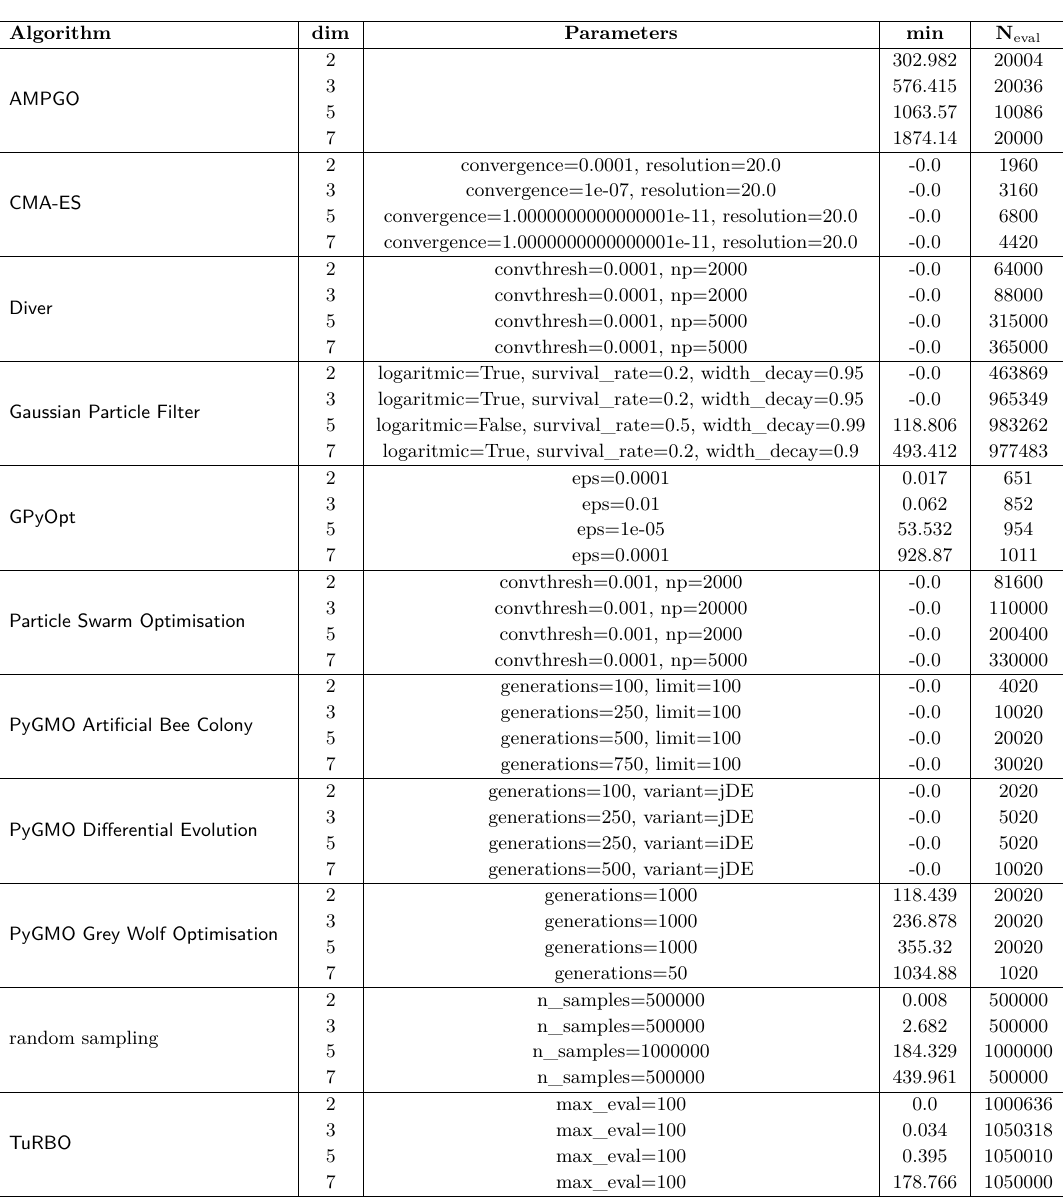
Table 6. Best obtained result for Analytic Function 4 (equation (3.4)). The ‘best’ result is the result with the lowest found function value. If multiple samples found the same value, the result with the fewest number of needed function evaluations is